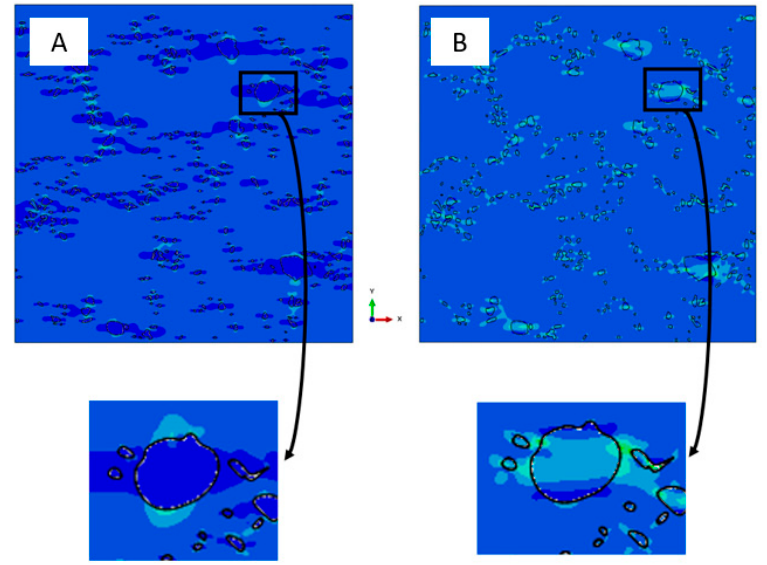
Figure 15. Local stress field in the X direction under ( A ) tension and ( B ) compression for nonbonded case.